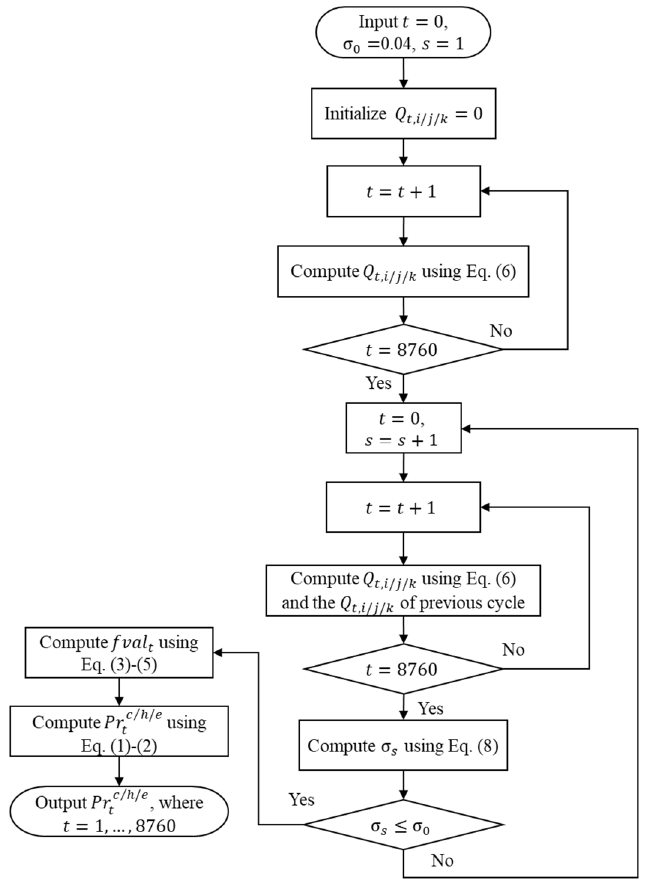
Figure 2. Flow chart of Algorithm (1).